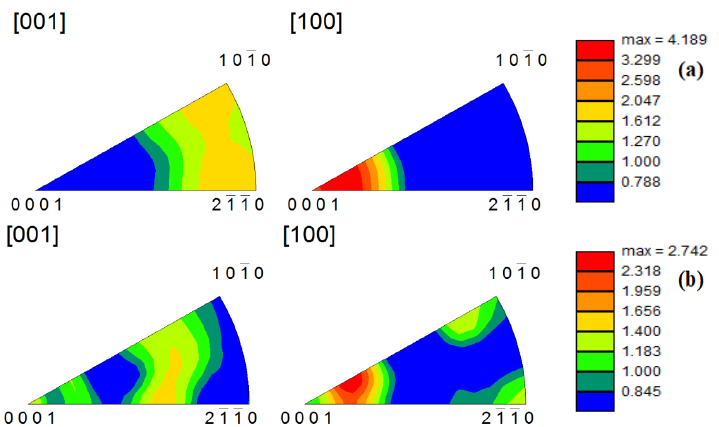
Figure 1 0 . Anti-pole diagrams of the alloy during hot compression at 0.001 s −1 ( a ) 653 K; ( b ) 733 K. Figure 10. Anti-pole diagrams of the alloy during hot compression at 0.001 s − 1 ( a ) 653 K; ( b ) 733